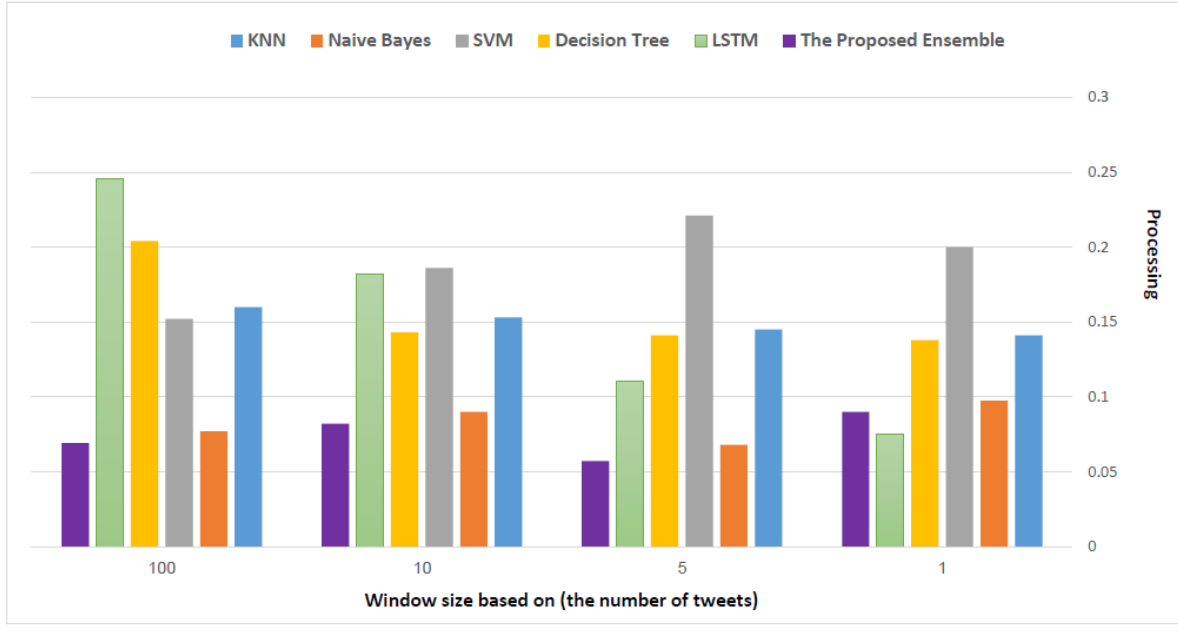
Figure 9. Processing time of models classification based on window size.